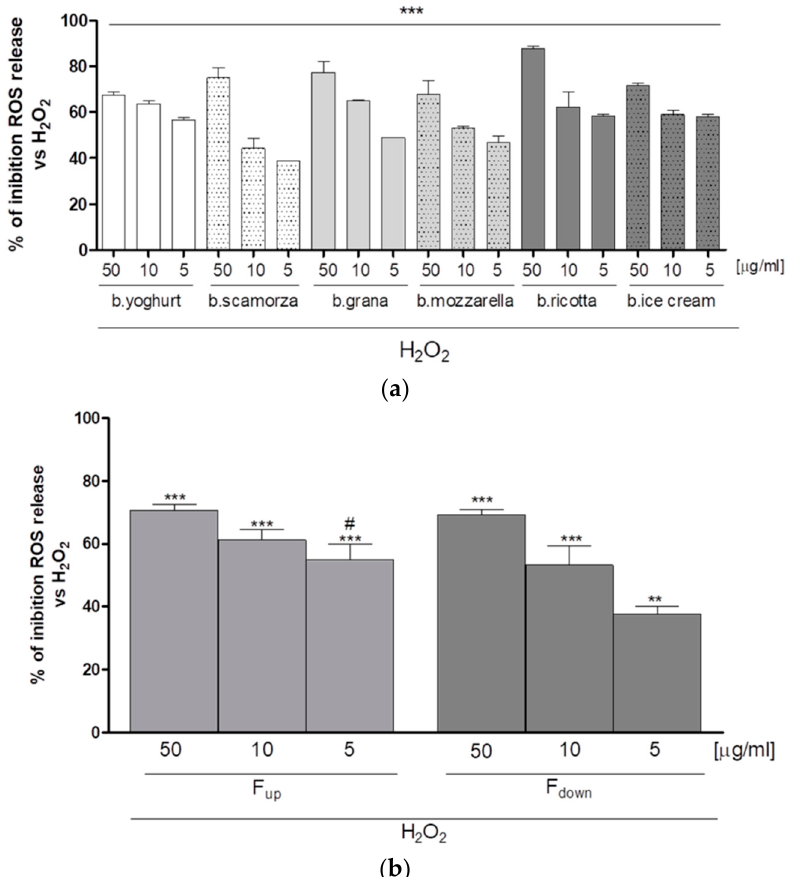
Figure 1. Effect on ROS formation, in IEC-6 cells, evaluated with the probe 2 ′ ,7 ′ dichlorofluorescein-diacetate of buffalo-milk dairy products ( a ) and buffalo ricotta peptide fractions, F up and F down ( b ). Values, mean ± s.e.m., are expressed as the % of inhibition of ROS release vs. H 2 O 2 . *** and ** denote p < 0.001 and p < 0.01 vs. H 2 O 2 and # denotes p < 0.05 vs. F down .